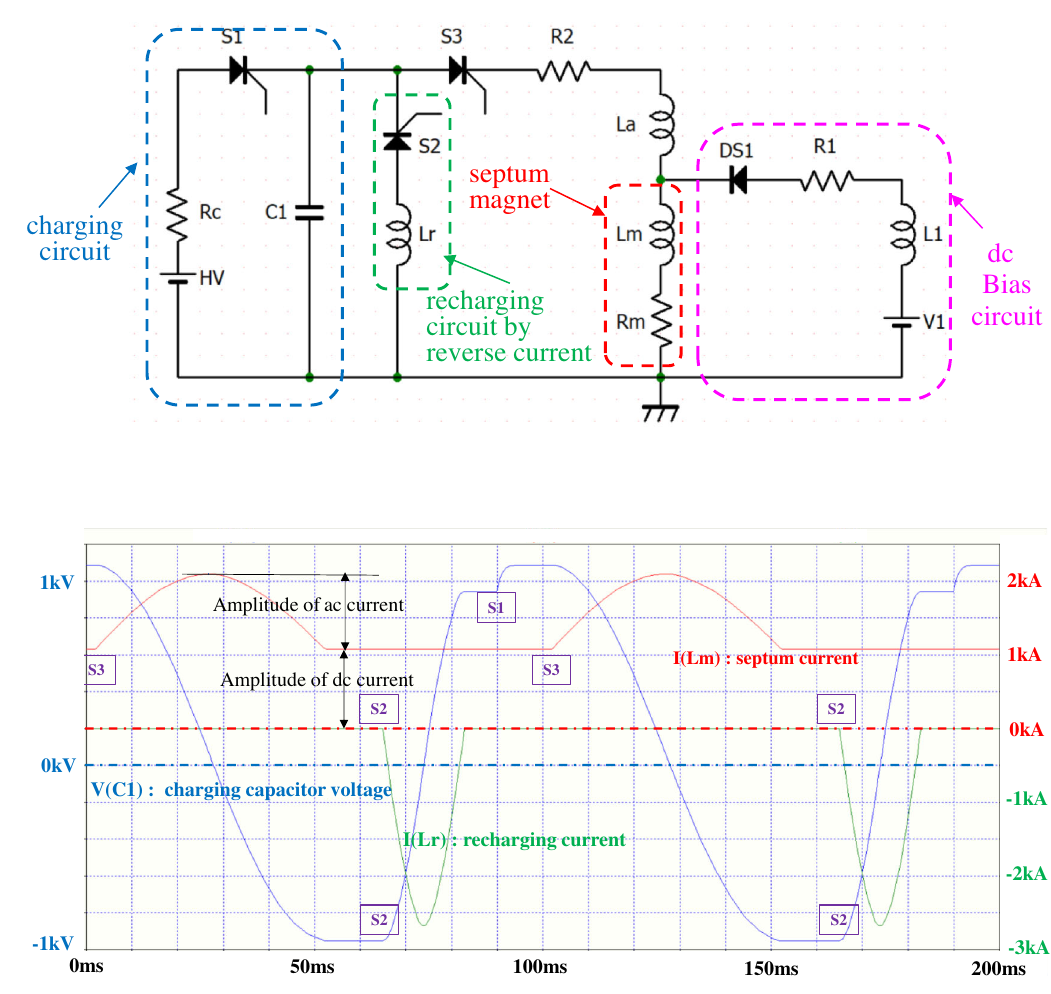
FIG. 13. Upper: circuit architecture for the septum magnet; lower: LT S pice simulation results, charging voltage of capacitor ( C 1 ), recharging current and excitation current of septum magnet for energy sweeping extraction, where [Sn] indicates the trigger timing of SCR “ Sn, ” where Lm of 24 μ H, Rm of 0 . 38 m Ω , and C1 of 15.92 mF are